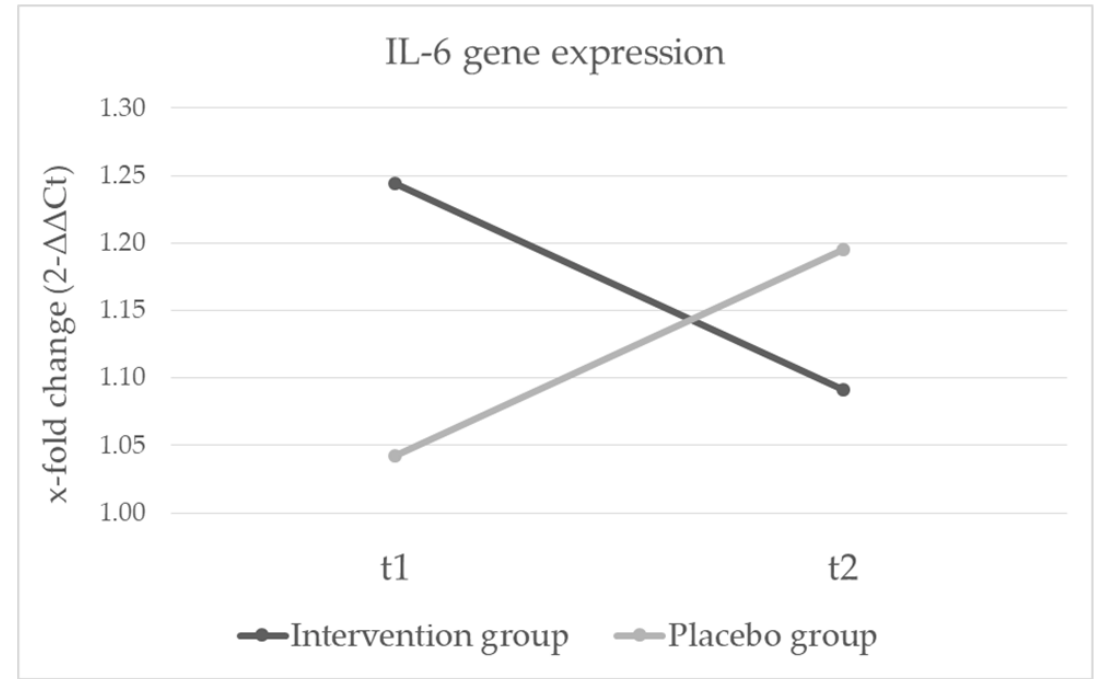
Figure 3. Changes in IL-6 gene expression after four weeks of probiotic treatment in individuals with depression (time x group interaction p = 0.022).